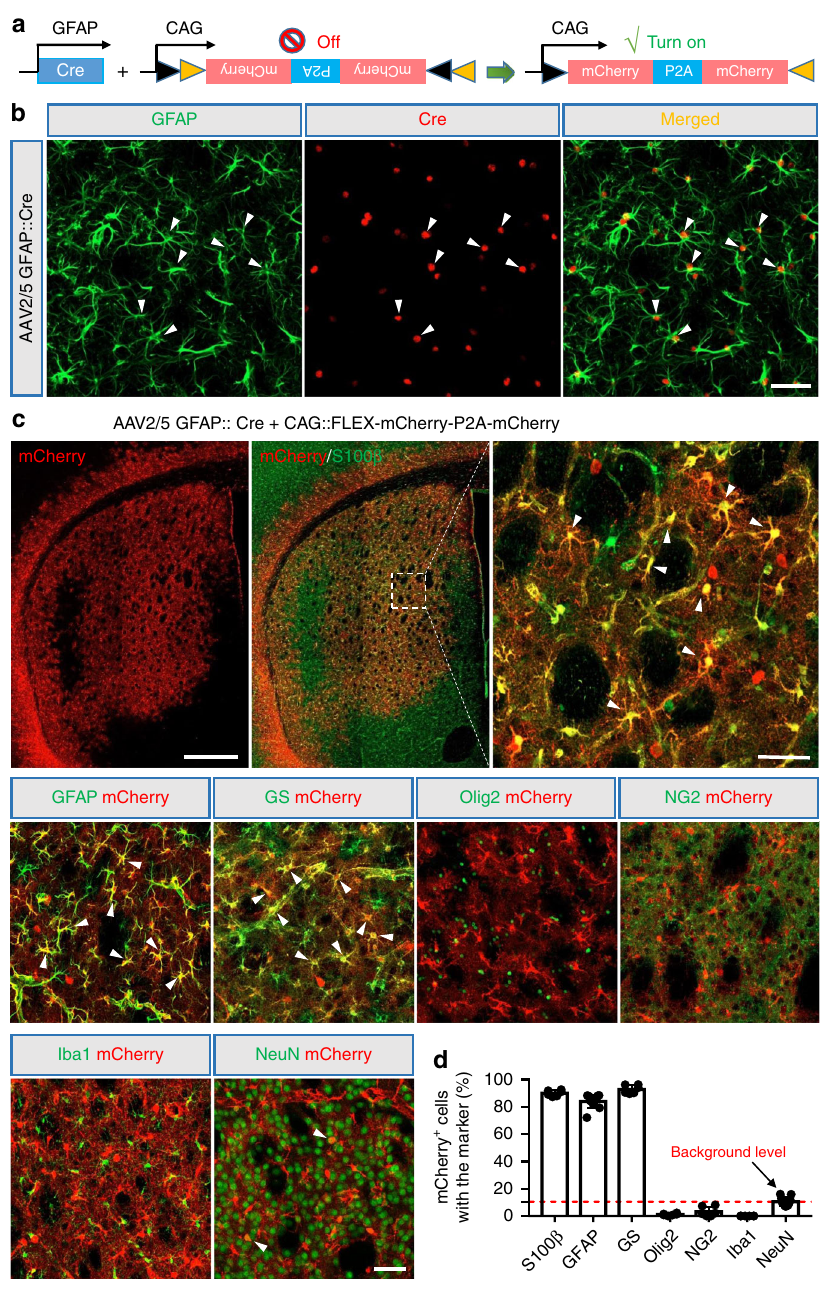
Fig. 1 Engineered AAV2/5 Cre-FLEx system infects striatal astrocytes speci fi cally in the adult mouse brain. a Schematic diagram of our engineered AAV2/5 constructs (GFAP::Cre and FLEx-CAG::mCherry-P2A-mCherry) used to target astrocytes speci fi cally with GFAP promoter-controlled expression of Cre recombinase, which in turn will activate the expression of mCherry. b Cre recombinase (red) was detected speci fi cally in GFAP + astrocytes (green) at 7 days post viral injection (dpi) of AAV2/5-GFAP::Cre. White arrowheads indicate astrocytes with Cre expression. Scale bar: 50 µ m. c Tiled confocal image of the striatum after control AAV mCherry injection (top left) (30 dpi), and the overlaid images of mCherry with a variety of glial markers or neuronal marker (NeuN). S100 β , GFAP, and glutamine synthetase (GS) are markers for astrocytes; Olig2 for oligodendrocytes; NG2 for NG2 expressing cells; and Iba1 for microglia. Arrowheads indicate some colocalized cells. Scale bar: 0.5 mm for the top tiled low-magni fi cation images, and 50 µ m for the high magni fi cation images. d Percentage of mCherry + cells in colocalization with different cell markers in the striatum. Note that the majority of control mCherry virus-infected cells were astrocytes. Data are shown as mean ±